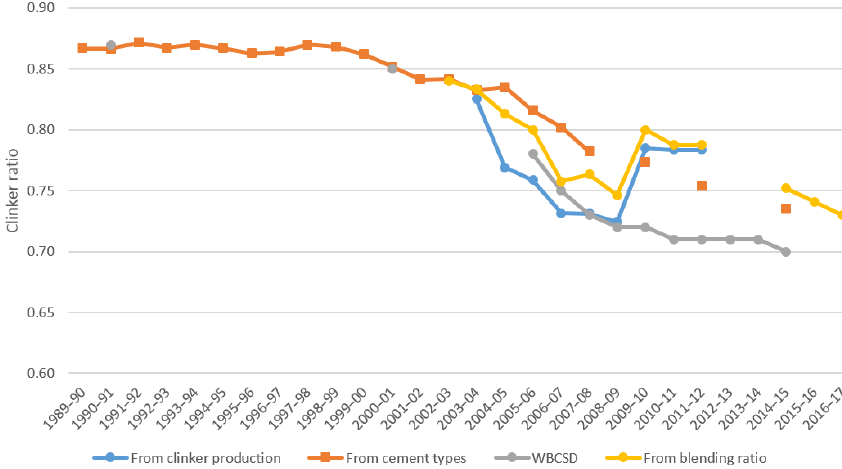
Data include clinker production, blending ratio (the inverse of clinker ratio), and cement types. When calculating clinker ratios from clinker and cement production data, clinker trade has been taken into account.